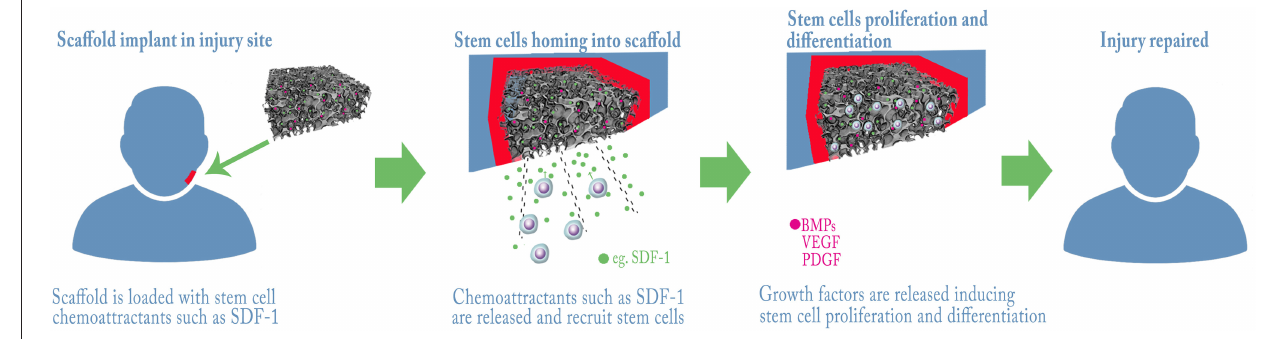
FIGURE 1 | Example strategies for bone regeneration trough Stem Cells recruitment and activation. A scaffold with control release of chemo-attractants and/or growth factors is grafted into the lesion, endogenous stem cells are attracted and home into the scaffold where they proliferate and differentiate repairing the tissue.